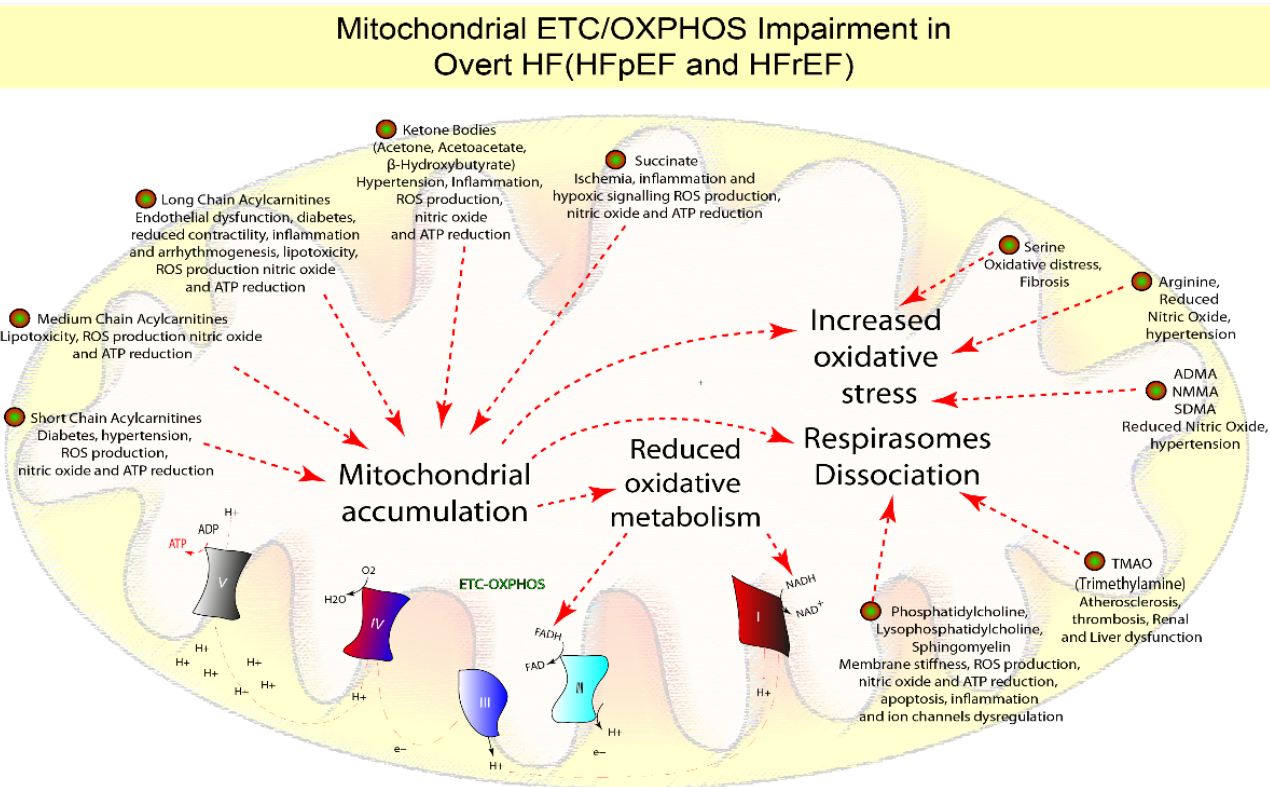
Figure 6. Suggested prognostic metabolites involved in ETC-OXPHOS dysfunction: Preclinical results suggest that mitochondrial dysfunction and decreased ETC-OXPHOS activity occur later after the beginning of both HF subtypes and are characterized by increased mitochondrial lipids, succinate, KB (mitochondrial dysfunction), asymmetric dimethylarginine (ADMA), symmetric dimethylarginine (SDMA), and N-monomethylarginine (NMMA) (oxidative stress), TMAO, or decreased phospholipids (respirasomes dissociation, complexes I, II, III, IV and V), arginine, and serine (oxidative stress). According to the microvascular dysfunction origin of the disease of HFpEF, decreased arginine and serine, as well as increased asymmetric dimethylarginine, symmetric dimethylarginine, and N-monomethylarginine, may be appropriate biomarkers at this stage, indicating mitochondrial dysfunction. Reduced phosphatidylcholine and an increase in TMAO in HFrEF may be useful indicators of mitochondrial dysfunction associated with neurohormonal dysfunction and direct cardiac damage disease-related